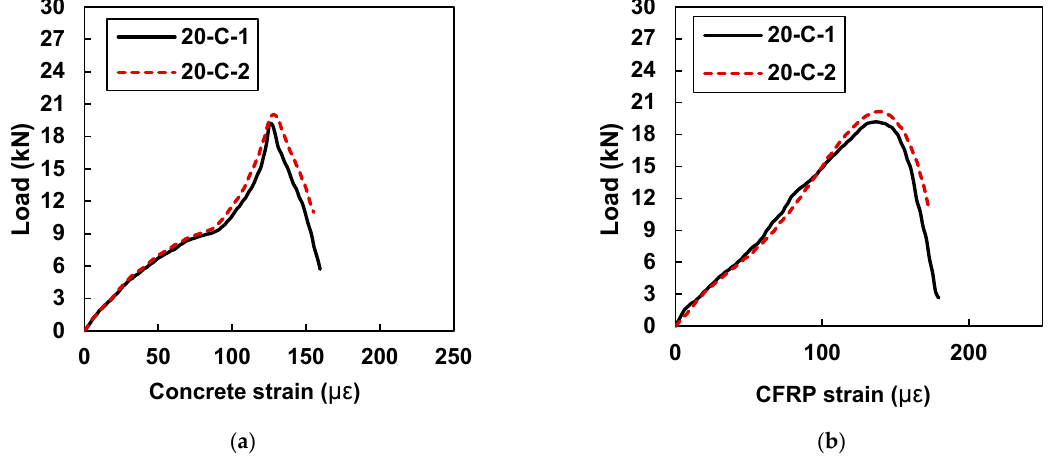
Figure 13. Load vs. strain curves for specimens with 10 mm CFRP strips (10-C-1 and 10-C-2): ( a ) strain in concrete and ( b ) concrete strain in CFRP. Figure 14 shows plots of load versus concrete microstrain and CFRP microstrains for samples 20-C-1 and 20-C-2.